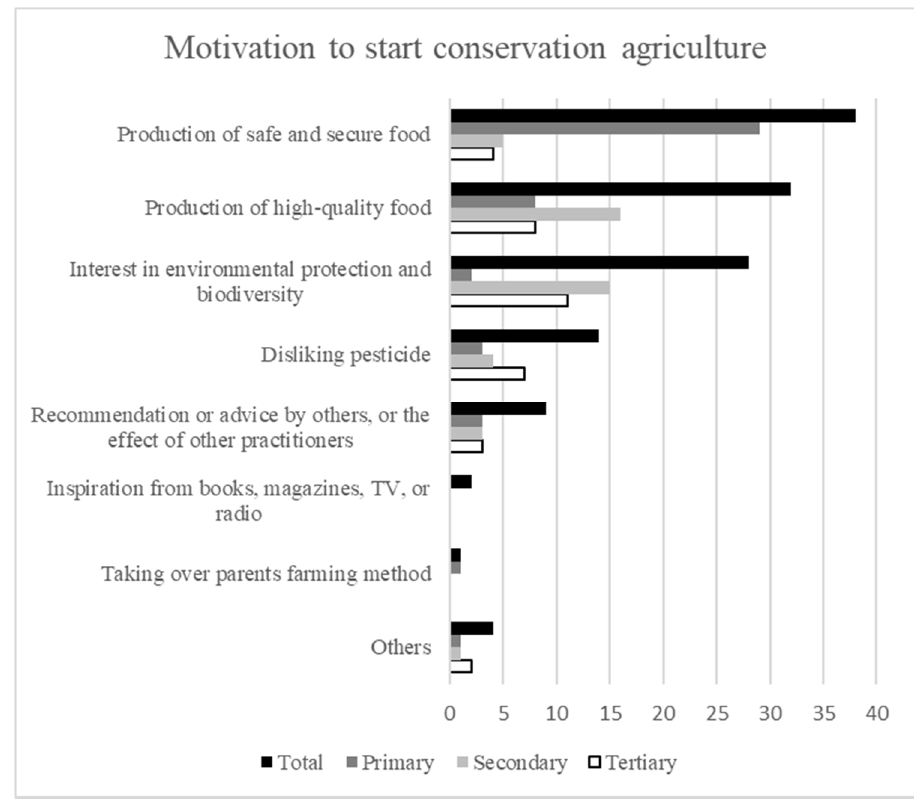
Figure 1. Ishikawa Prefecture farmers’ motivation to start conservation agriculture ( n = 47).